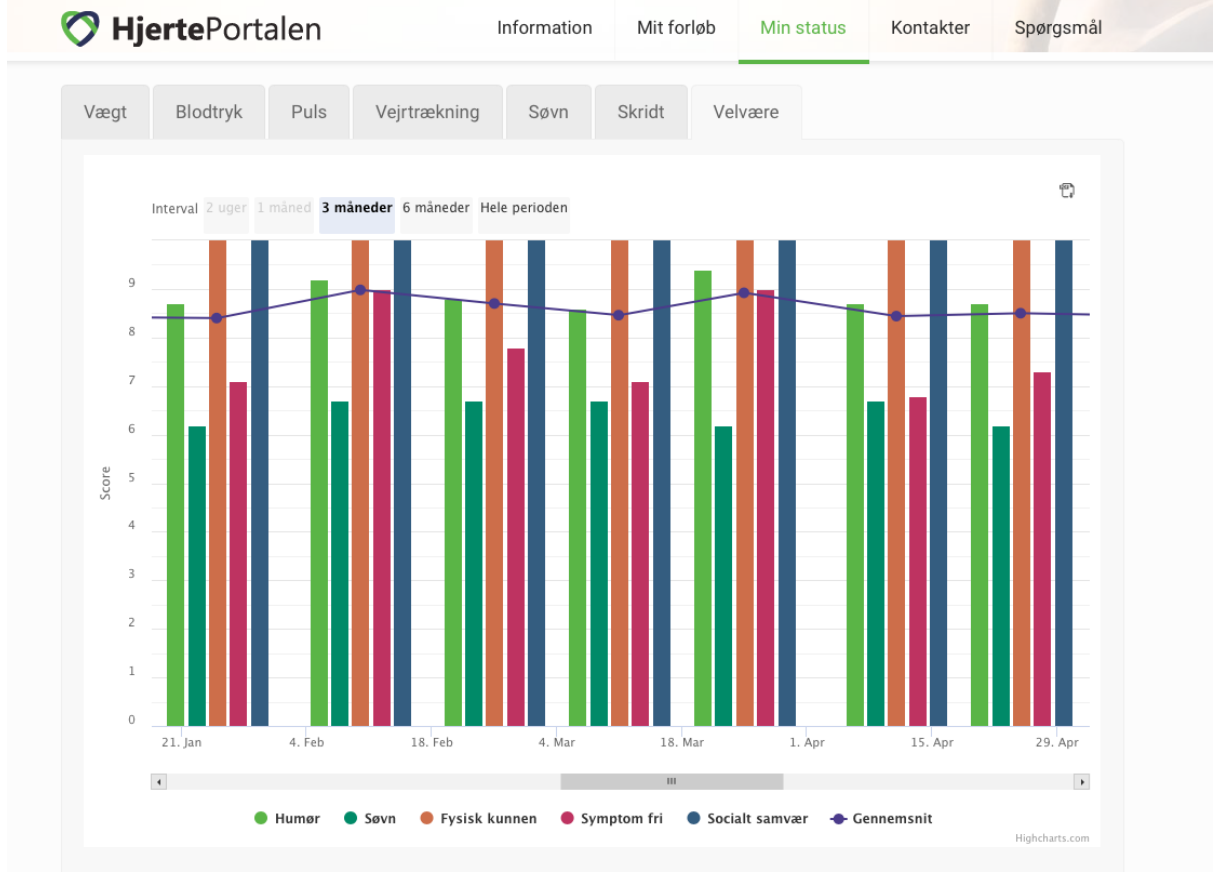
Figure 2. A screen capture of HeartPortal. An illustration of the patient-reported outcome. Row 1: Information, My Treatment, My Status, Contacts, and Questions; Row 2: Weight, Blood Pressure, Pulse, Breathing, Sleep, Steps, and Well-being; Row 3: Time Intervals (3 months, 6 months, and Entire period); and Row 4 (bottom): Mood (light-green dot), Sleep (dark-green dot), Physical condition (orange dot), Symptom-free (red dot), Social contact (blue dot), and Mean (blue